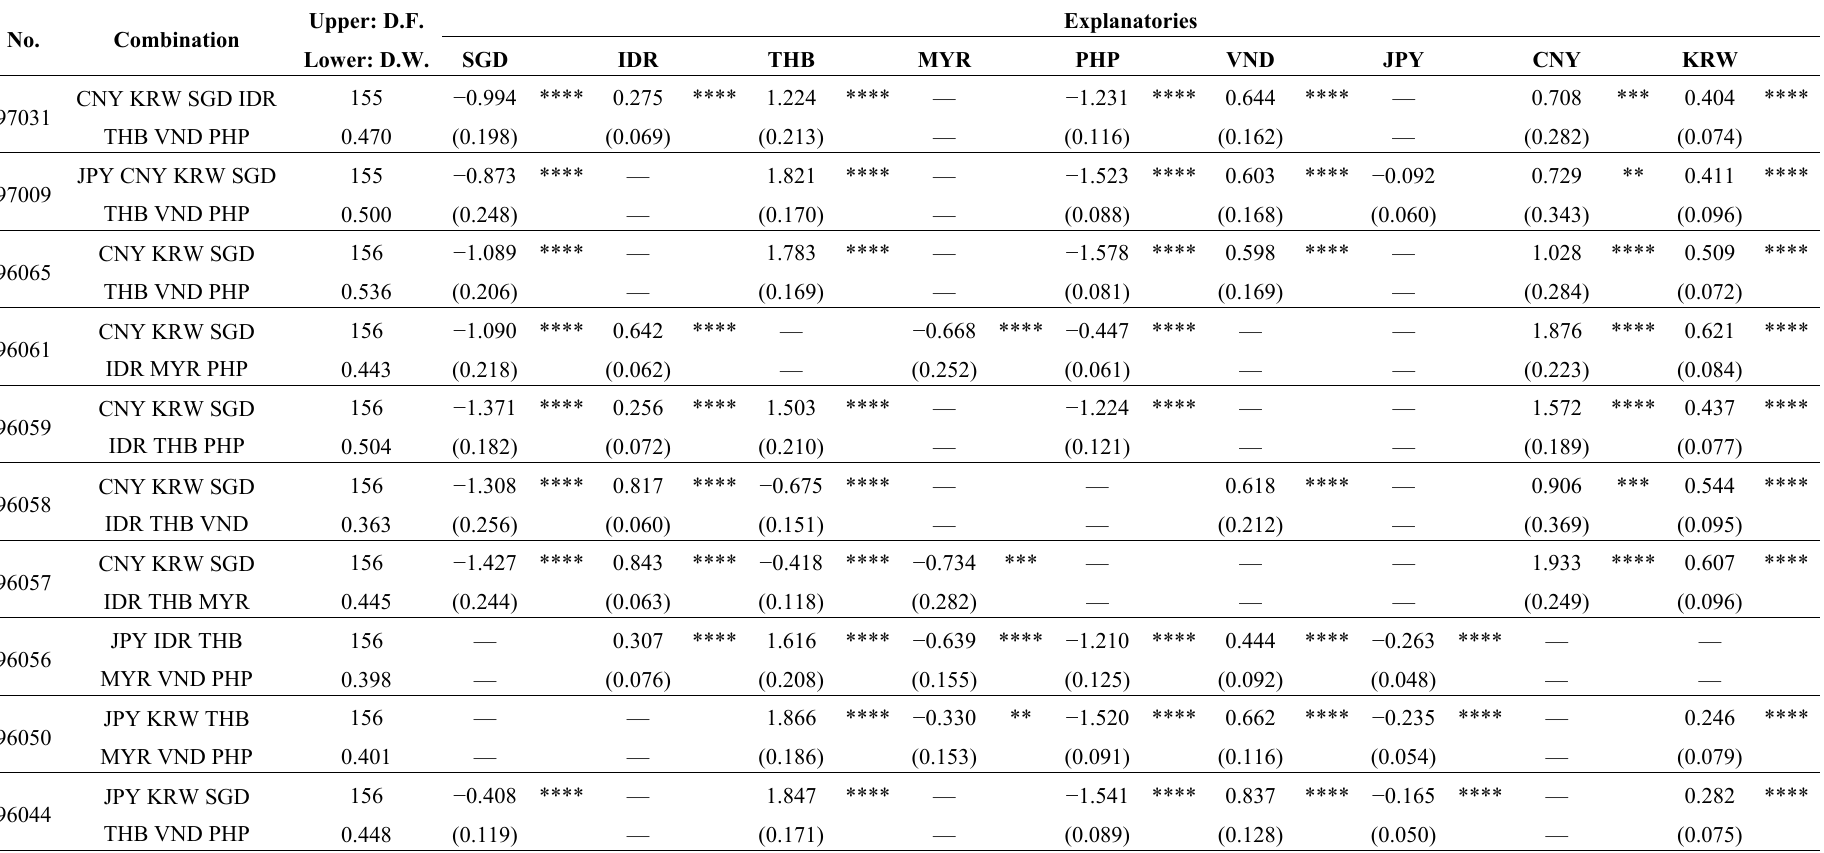
Table 1. OLS Estimation for Asymmetric Integration (January 2000–June